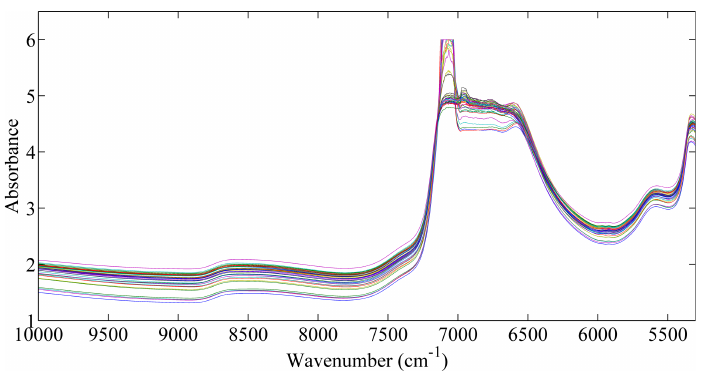
Fig. 1. Original raw NIR spectra of 56 samples taken from HA fermentation broth.